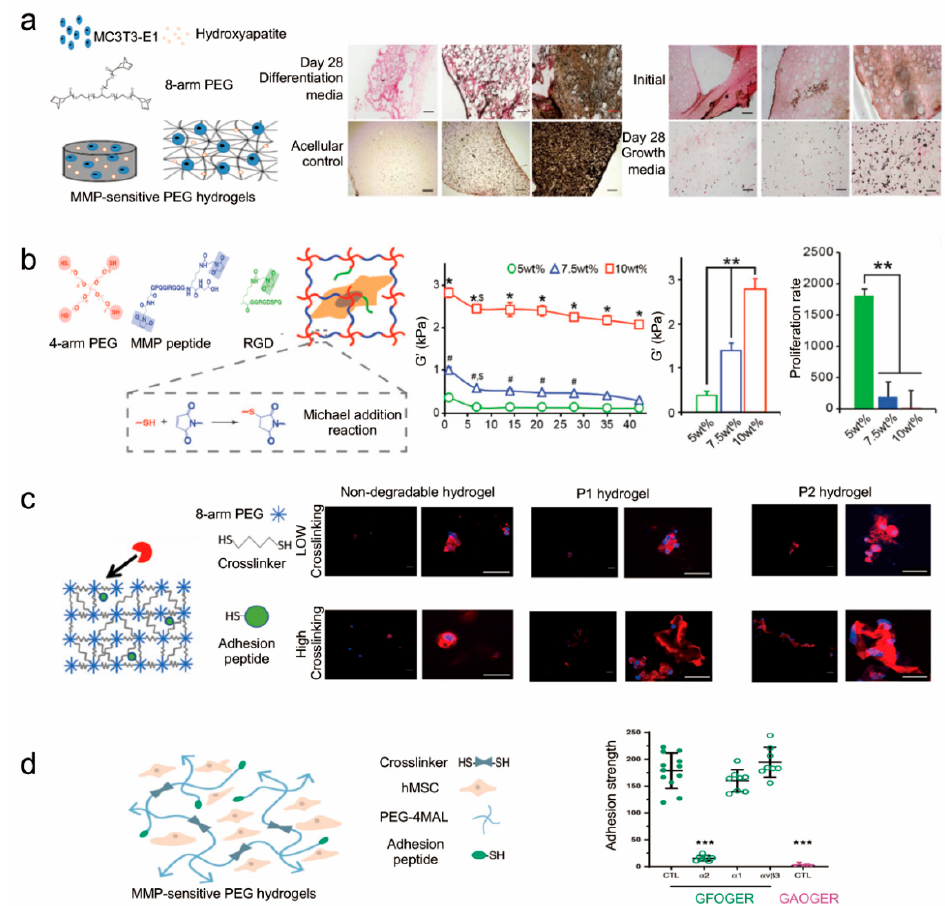
Figure 6. Hydrogel-based 3D in vitro models for studying cellular responses. ( a ) The nHAPs have also been embedded in MMP-cleavable peptides-based hydrogels to promote osteogenesis [113]. Reprinted with permission from Copyright © 2018 IOP Publishing Ltd. ( b ) The stiffness of MMP-cleavable peptides-based hydrogels influenced cell proliferation [105]. * p < 0.0001 for 10 wt% relative to 5 and 7.5 wt% at a given time point, # p < 0.05 for 7.5 wt% relative to 5 wt% at a given time point, $ p < 0.05 for a given time point relative to day 1, and ** p < 0.01 [105]. Reprinted with permission from Copyright © 2020 WILEY-VCH Verlag GmbH & Co. KGaA, Weinheim. ( c ) The degradation rates of MMP-cleavable peptides-based hydrogels are critical to accelerating early osteogenesis [121]. Reprinted with permission from Copyright © 2019 John Wiley and Sons. ( d ) Adhesive peptides of MMP-cleavable peptides-based hydrogels enhance the adhesion strength of cells [122]. ANOVA ( p < 0.0001) was used to detect statistical differences followed by Sidak’s multiple comparisons test with adjustment for multiple comparisons, *** p < 0.0001 vs. GFOGER CTL. Reprinted with permission from Copyright © 2020 Nature Publishing Group.